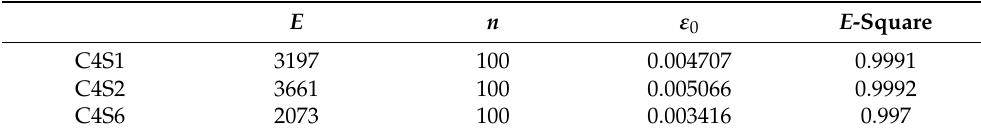
Table 1. Mechanical properties of the nonlinear elastic columns.